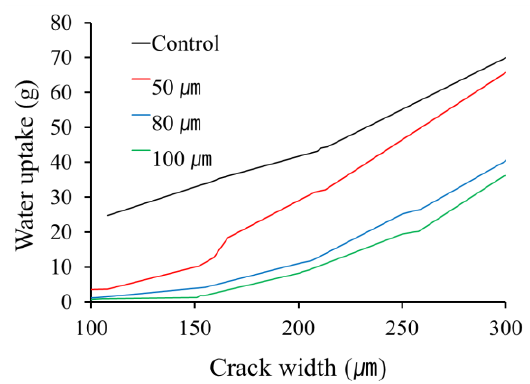
Figure 7. Water uptake versus crack width of the control and self-healing coatings having undercoating thickness of 50, 80 or 100 µm. Capsule-loading of the self-healing coatings was 20 wt% and mean microcapsule diameter was 65 µm.